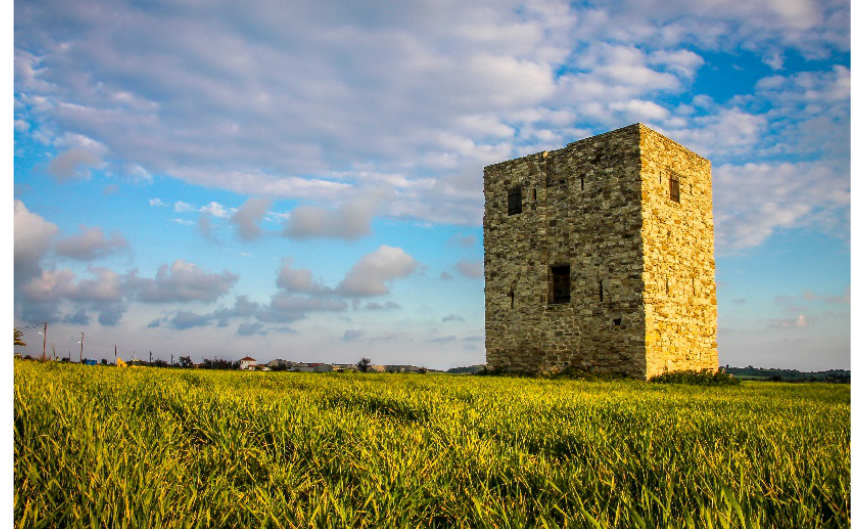
Figure 8. The Medieval tower of Alaminos at the locality of Kambos (Image by Adamos Papantoniou).